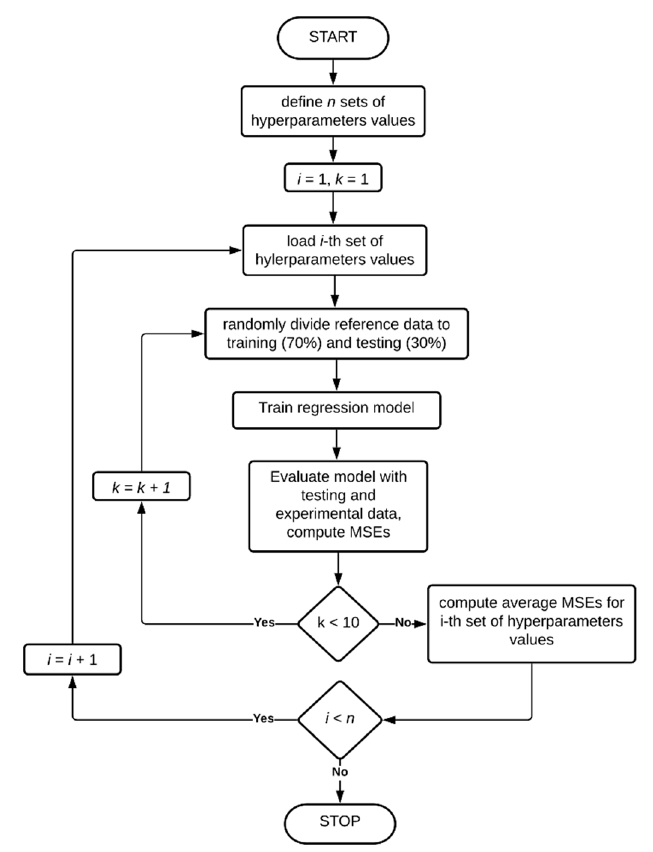
Figure 5. Algorithm for finding best hyperparameters values for each model.